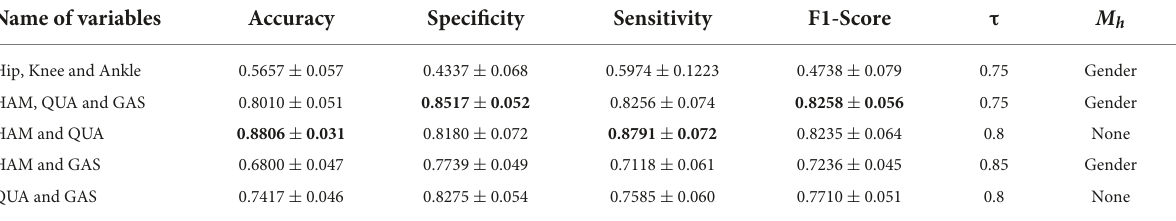
TABLE 5 Classification performance of FBI-GCN by removing some variables separately according to different outline